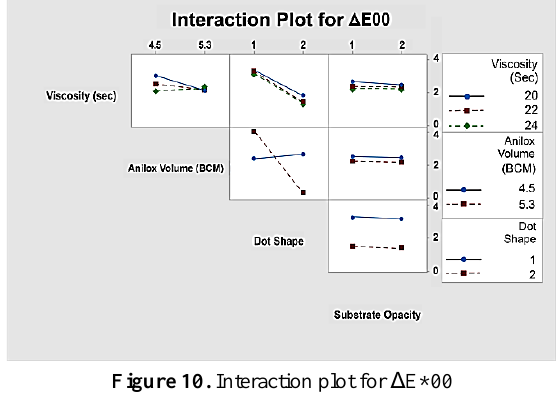
a* b* coordinates.